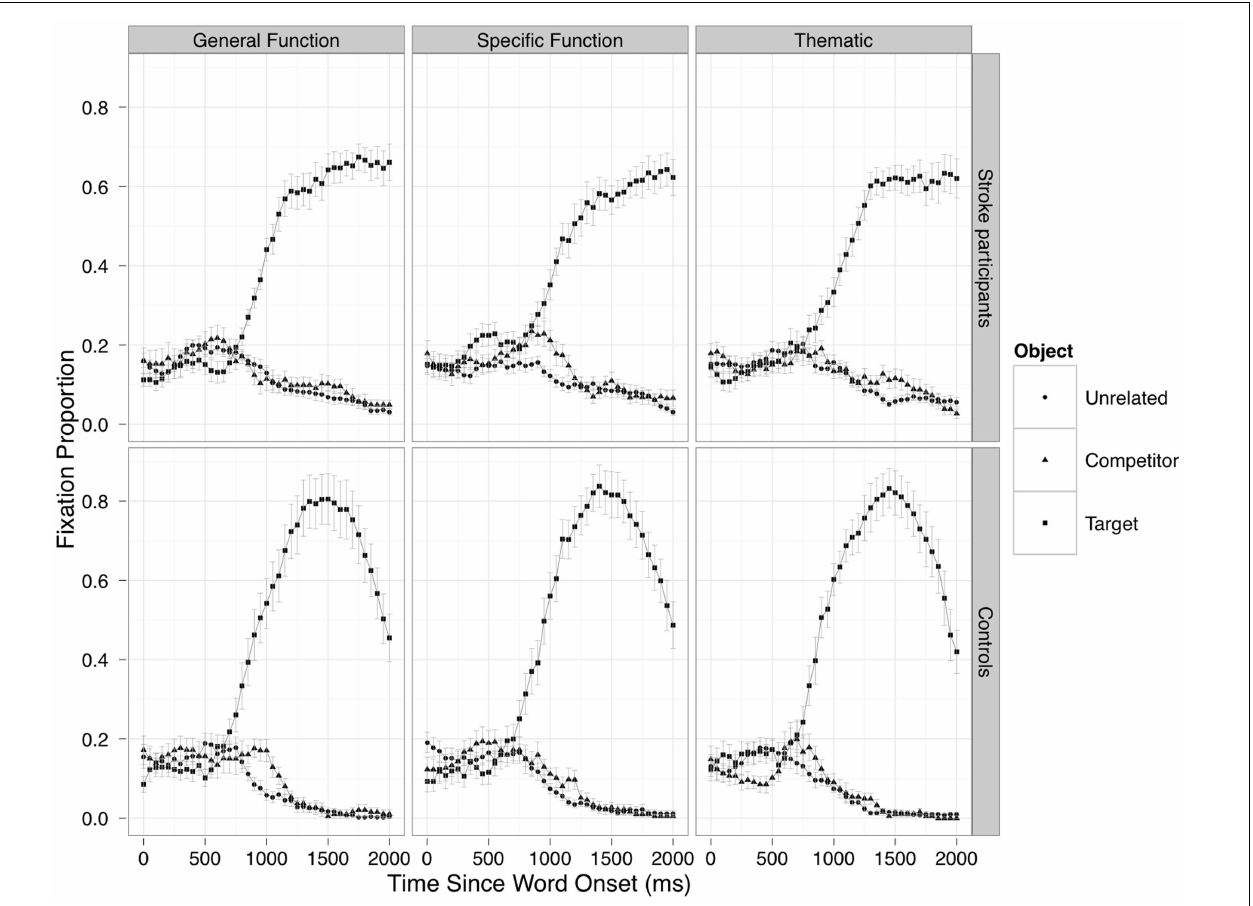
FIGURE 2 |Averaged time course of fixations to the target, competitor and unrelated objects from word onset in each display type for stroke (top) and control (bottom) participants.